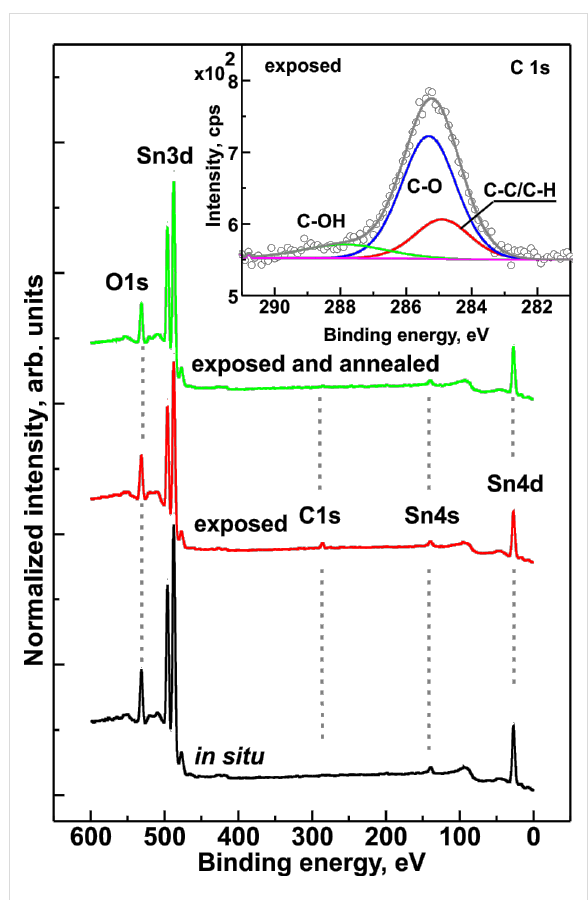
Figure 1: XPS survey spectra with the main core-level lines of RGVO SnO 2 nanolayers (pristine (“in situ”), after exposure to air (exposed) and after subsequent UHV annealing (exposed and annealed)). Inset: decomposed C 1s region for the air-exposed sample showing the main constituents of the carbon contamination.